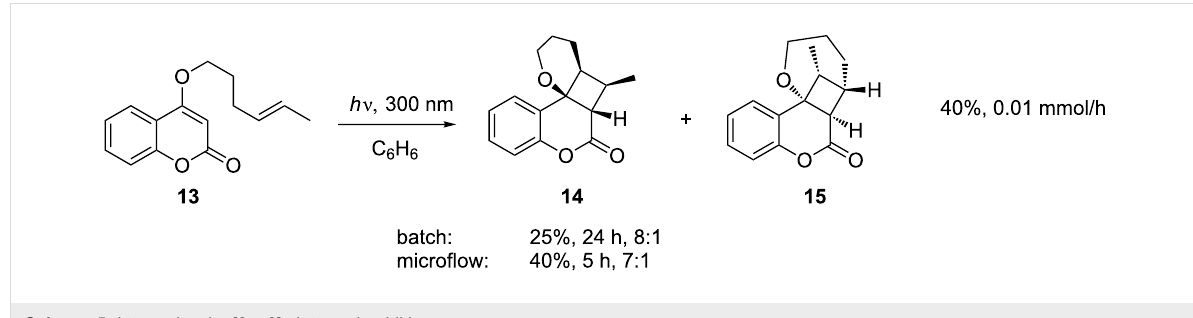
Scheme 5: Intramolecular [2 + 2]